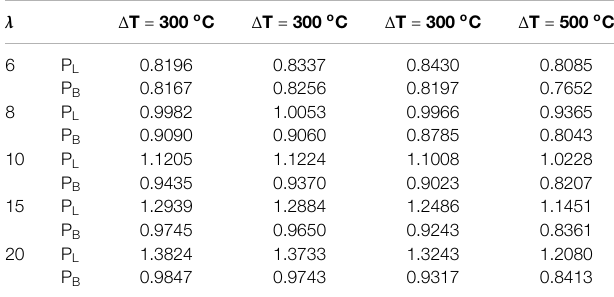
TABLE 1 | Buckling loads of arches with different geometric parameter ( S/h = 30, T 1 = 20 °